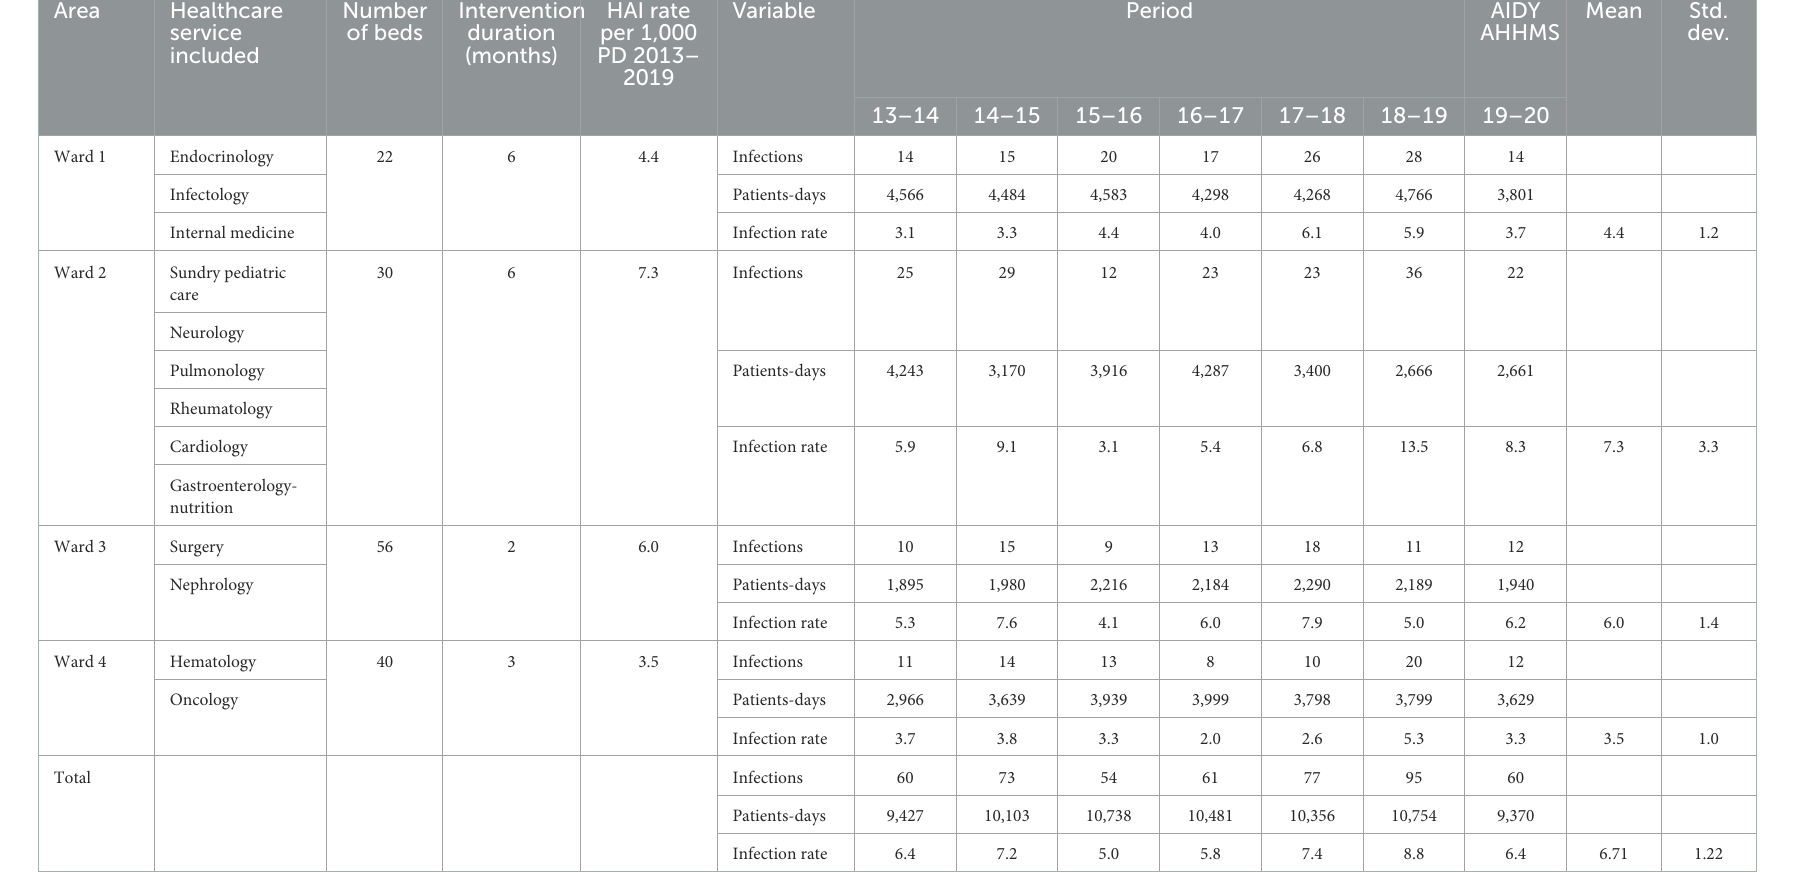
TABLE 1 Characteristics of the HIMFG wards